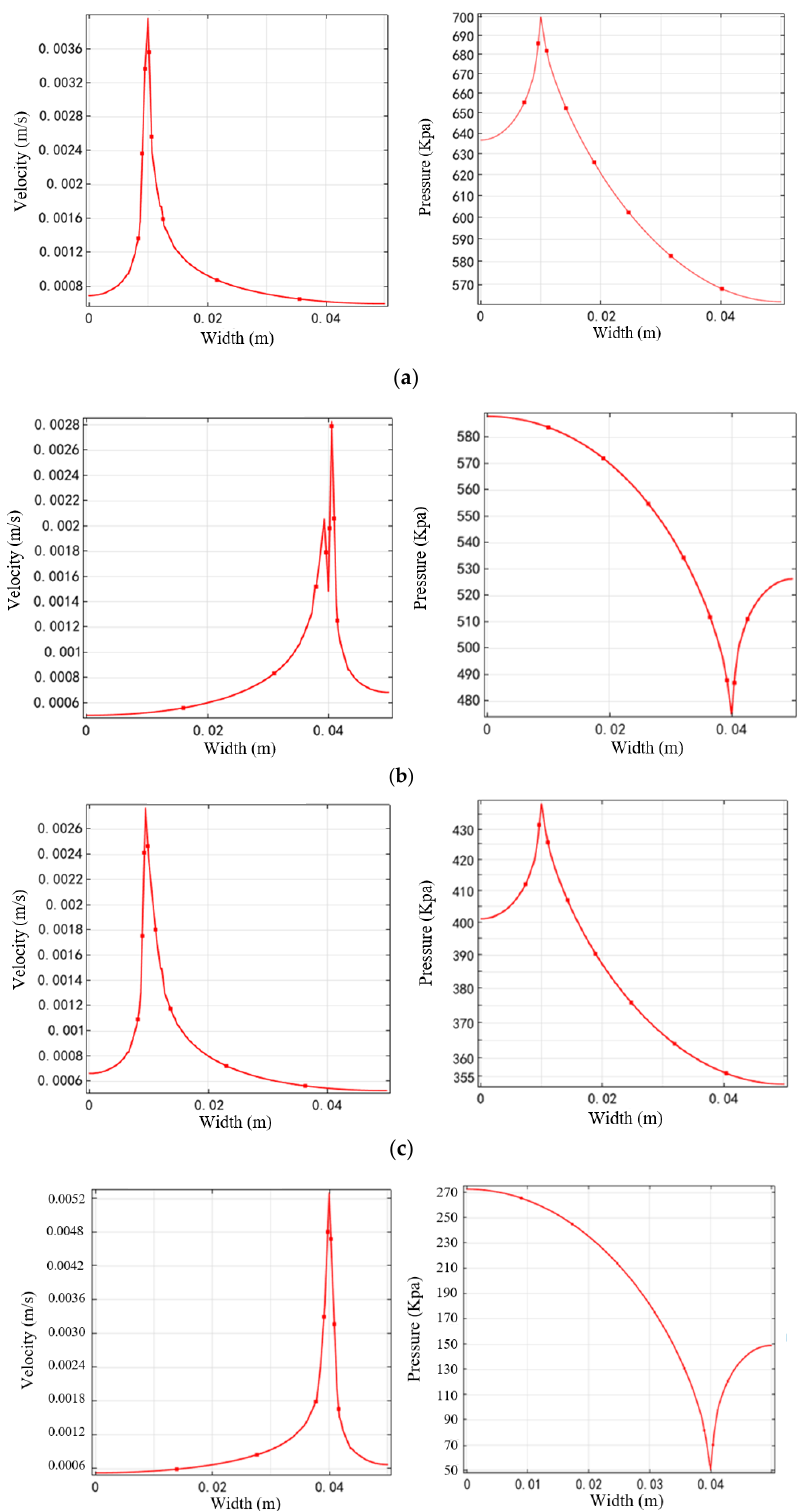
Figure 19. The locations of the transversal line. ( a ) Transversal line L 11 ; ( b ) transversal line L 21 ; ( c ) transversal line L 22 ; ( d ) transversal line L 31 .